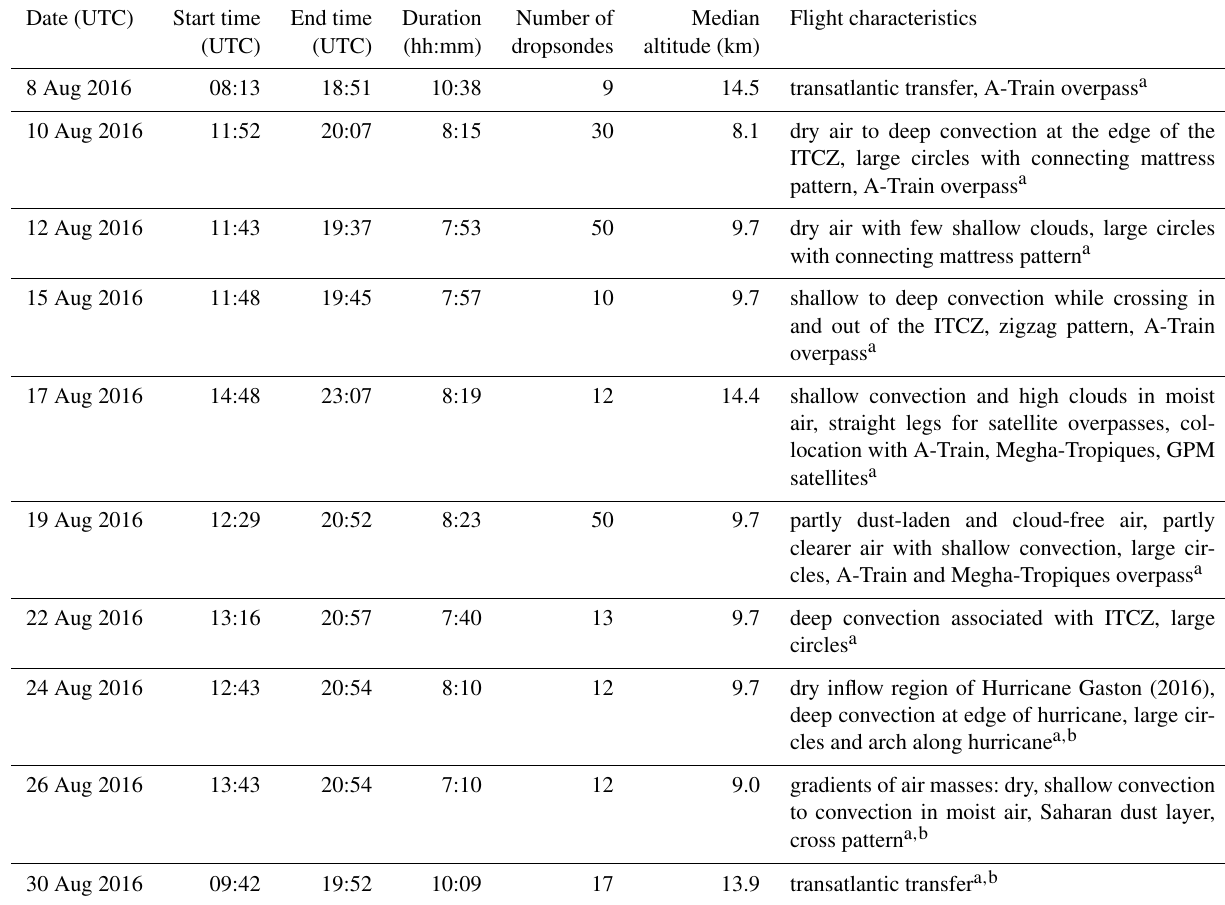
Table 3. List of NARVAL2